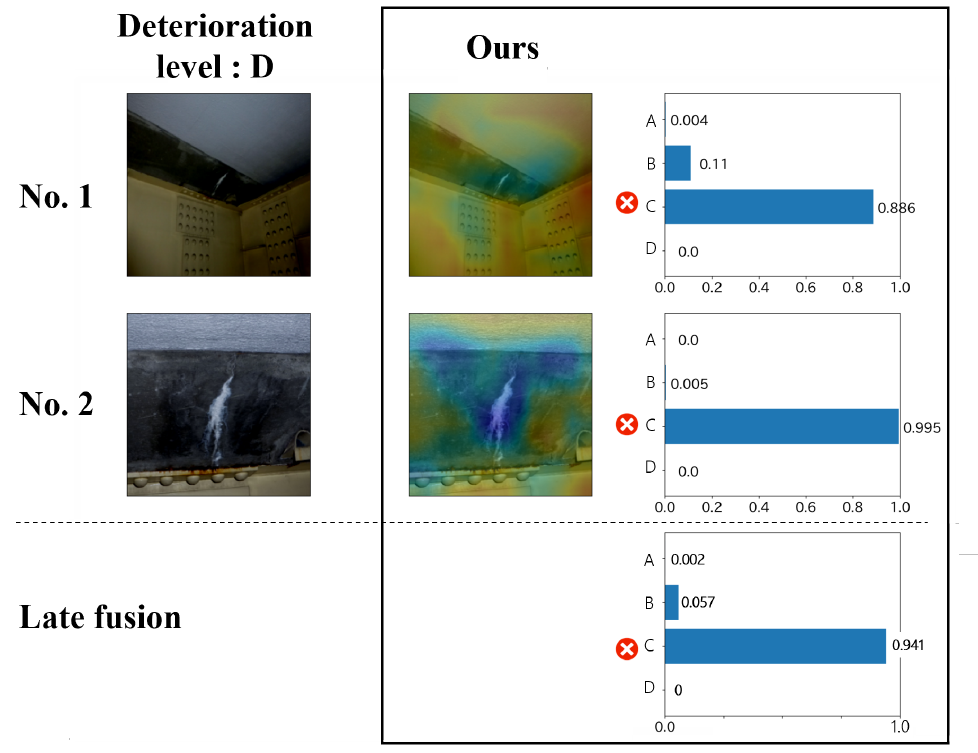
Figure 13. The example of incorrectly estimated results. The estimation performance for the image and record is degraded when the attention map is generated outside of the distress